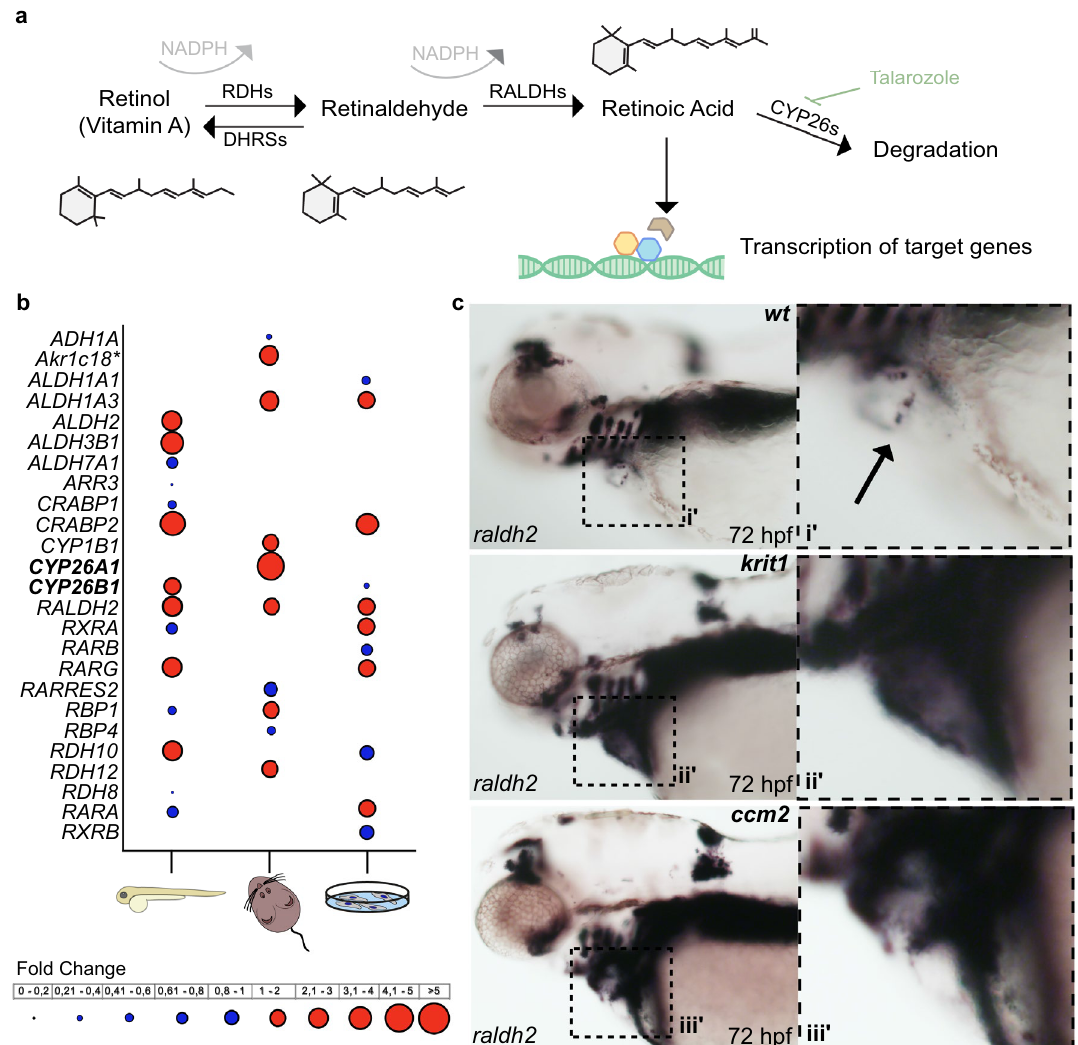
Figure 1. Expression of retinoic acid pathway components is misregulated in in vitro and in vivo models of CCM. (a ) Retinoic acid synthesis and degradation pathway. Synthesis of retinoic acid from Vitamin A (retinol) is dependent on availability of NADPH. In this study, all-trans RA and the Cyp26 inhibitor Talarozole were used to modulate RA levels. ( b ) Comparative expression levels of RA pathway genes in ccm2 mutant zebrafish hearts, pan-endothelial Ccm2 knock-out mouse veins, and siRNA CCM2-depleted HUVECs. Fold changes in expression levels are depicted in circle sizes (grouped by fold changes between 0 and 5, see legend). Downregulated transcripts are represented with blue circles whereas upregulated genes are shown in red circles. Transcripts not represented in the datasets do not contain a circle. Gene names are represented as human orthologs except for genes for which only co-orthologs are known (marked with asterisks). ( c ) Whole-mount in situ hybridization of raldh2 performed on 72 hpf old zebrafish and magnifications of the heart region (see box). Stained valve leaflets are marked by an